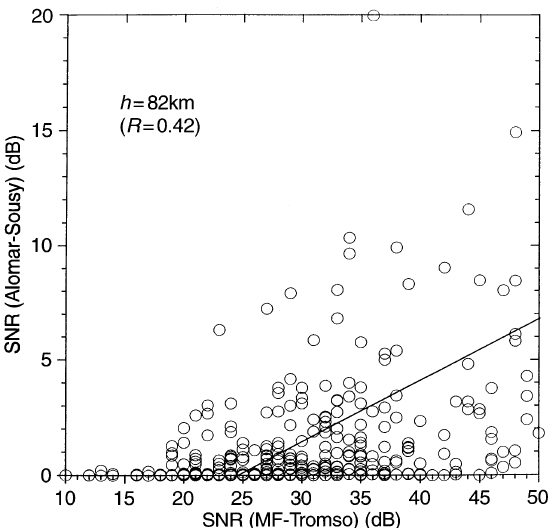
Fig. 6. Correlogram of hourly SNR values derived from ALOMAR SOUSY and MF-radar observations at an altitude of 82 km to- gether with the best-fit